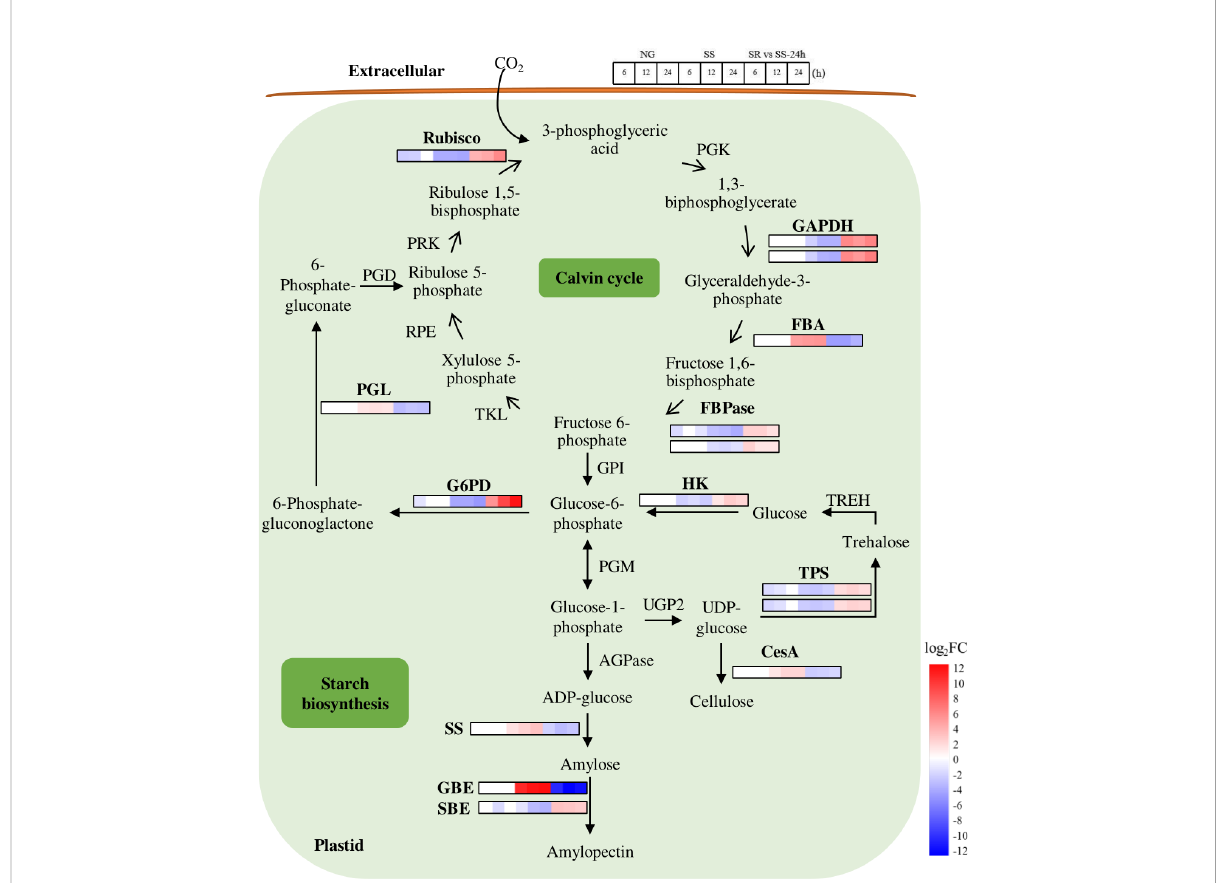
FIGURE 6 Expression patterns of identi fi ed SRV-DEGs in starch synthesis pathway of C. sorokiniana. Rubisco, RuBP carboxylase/oxygenase; PGK, 3- phosphoglycerate kinase; GAPDH, glyceraldehyde 3-phosphate dehydrogenase; FBA, fructose-bisphosphate aldolase; FBPase, fructose 1,6- bisphosphatase; TKL, transketolase; RPE, ribulose 5-phosphate 3-epimerase; PRK, phosphoribulokinase; G6PD, Glucose-6-phosphate dehydrogenas; PGL, 6-phosphogluconolactonase; PGD, phosphogluconate dehydrogenase; GPI, phosphoglucose isomerase; PGM, phosphoglucomutase; AGPase, ADP glucose pyrophosphorylase; SS, starch synthase; GBE, glycogen-branching enzyme; SBE, starch branching enzyme; UGP2: UTP-glucose-1-phosphate uridylyltransferase 2; TPS, alpha-trehalose-phosphate synthase; CesA, cellulose synthase; TREH, alpha-trehalase; HK, Hexokinase. Color legends are shown at the bottom right of the map. The time points of the genes ’ expression pattern are shown at the top right of the